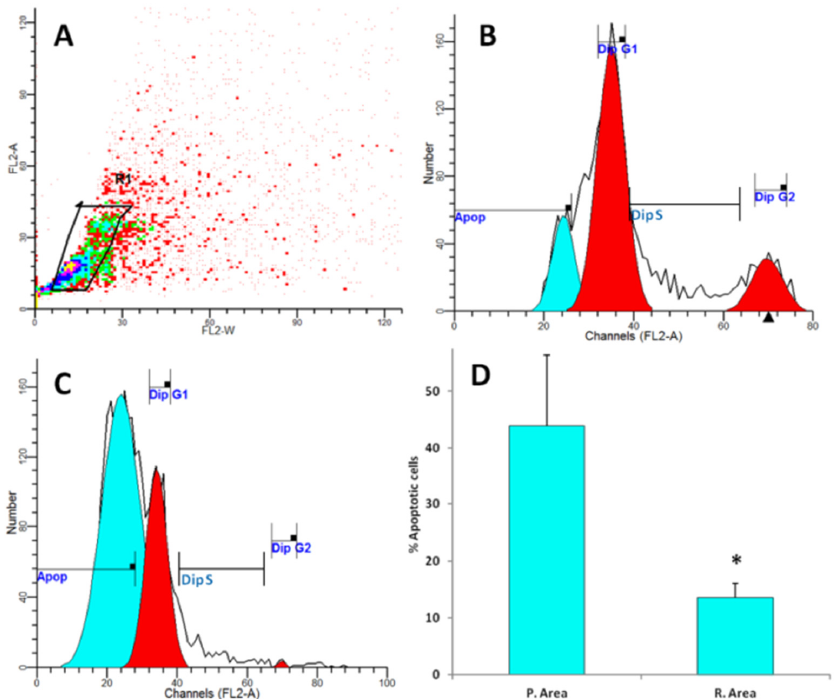
Figure 2. Representative flow cytometry histograms demonstrating the cell cycle phases as determined by propidium iodide staining. ( A ) gating out doublet events on the basis of FL-2A versus FL-2W; ( B , C ) cell cycle phases of hepatic tissues from reference and polluted area respectively; ( D ) the average of apoptotic cells percentage. Values represent the means ± SD, * p < 0.05 (Student t -test).